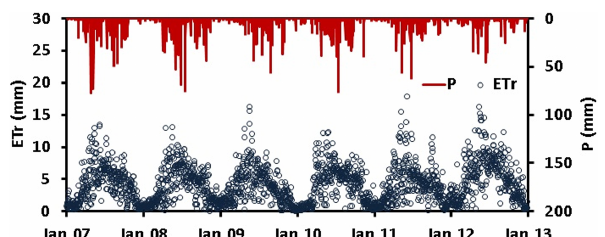
Figure 3. Daily precipitation ( P ) and reference evapotranspiration (ET r ) during the calibration (2008–2010) and validation (2011– 2012) periods at the Mead rain-fed (US-Ne3)